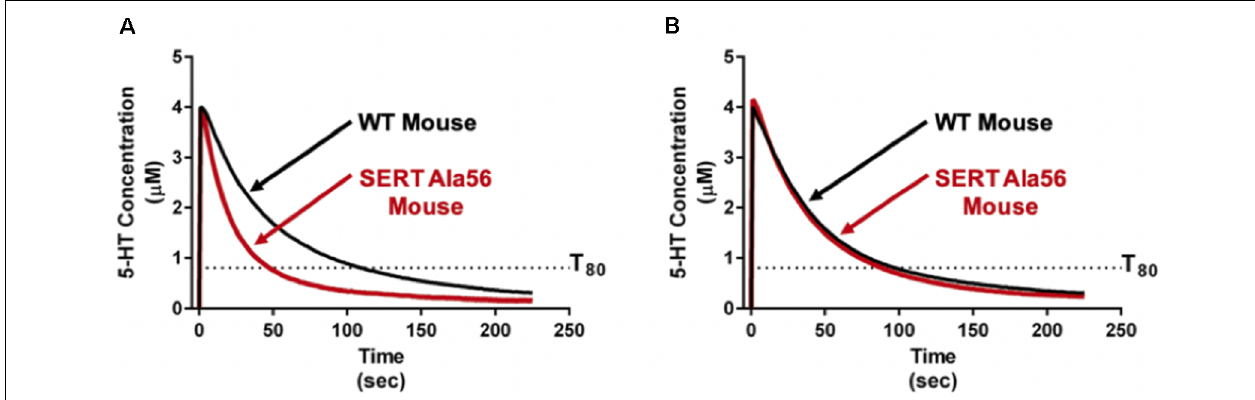
FIGURE 4 | Pharmacological p38 α MAPK inhibitor administration normalizes in vivo hippocampal 5-HT clearance rates in SERT Ala56 mice. (A) SERT Ala56 mice exhibit an elevated rate of hippocampal 5-HT clearance as compared to their SERT Gly56 counterparts when assessed by high-speed in vivo chronoamperometry. (B) Increased 5-HT clearance rate of SERT Ala56 mice is normalized to WT rates by repeated p38 α MAPK inhibition with MW150 (5 mg/kg, QD, i.p. × 7 days). Figure adapted from Robson et al.